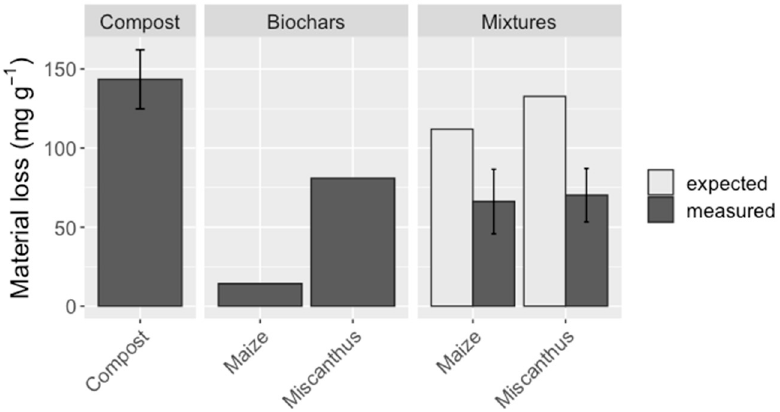
Figure 1. Total mass loss during physical weathering of compost, biochars and their mixtures. Data are presented as mean ± sd ( n = 2 for the compost and the mixture and n = 1 for the biochars). Expected values for mixtures were calculated based on mass losses measured for individual components.